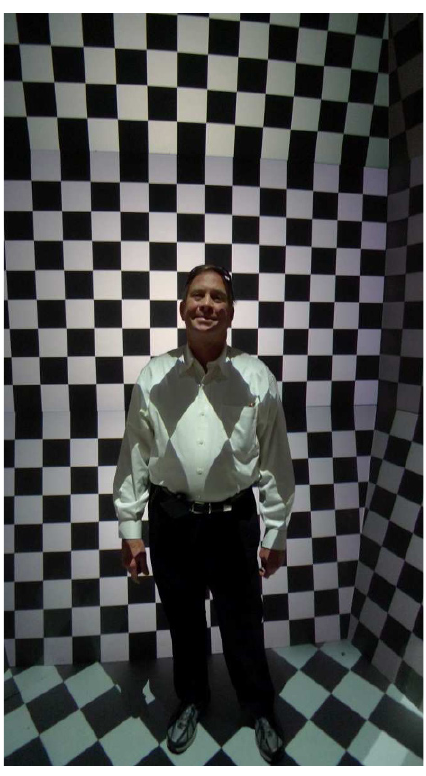
Figure 17. Calit2 StarCAVE checkerboard pattern. Photo: Jurgen Schulze.